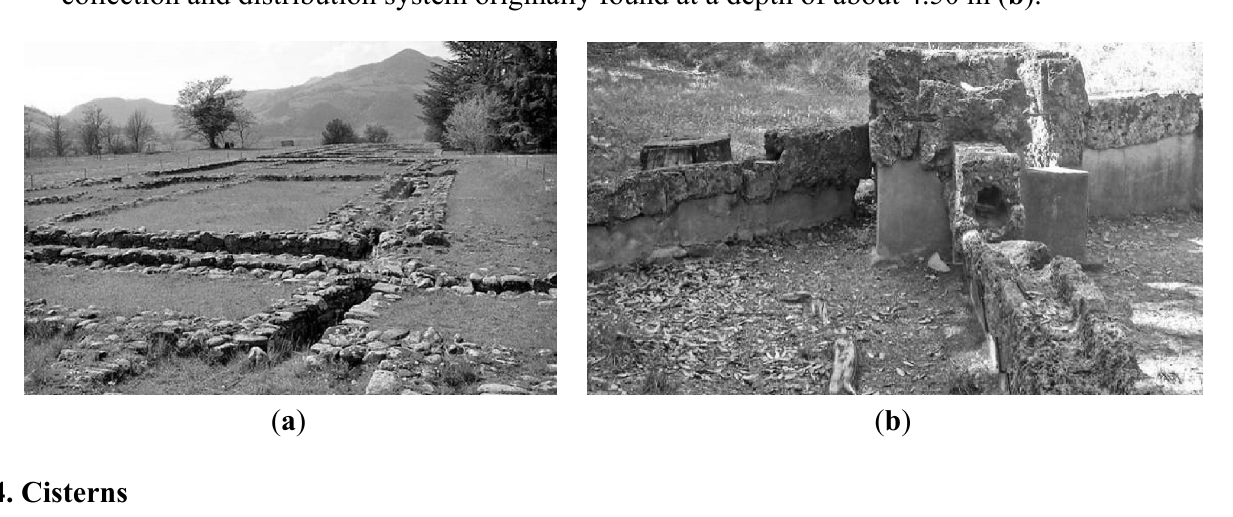
Figure 2. Etruscan archaeological site of Marzabotto, Central Italy: general view ( a ) and collection and distribution system originally found at a depth of about 4.50 m ( b